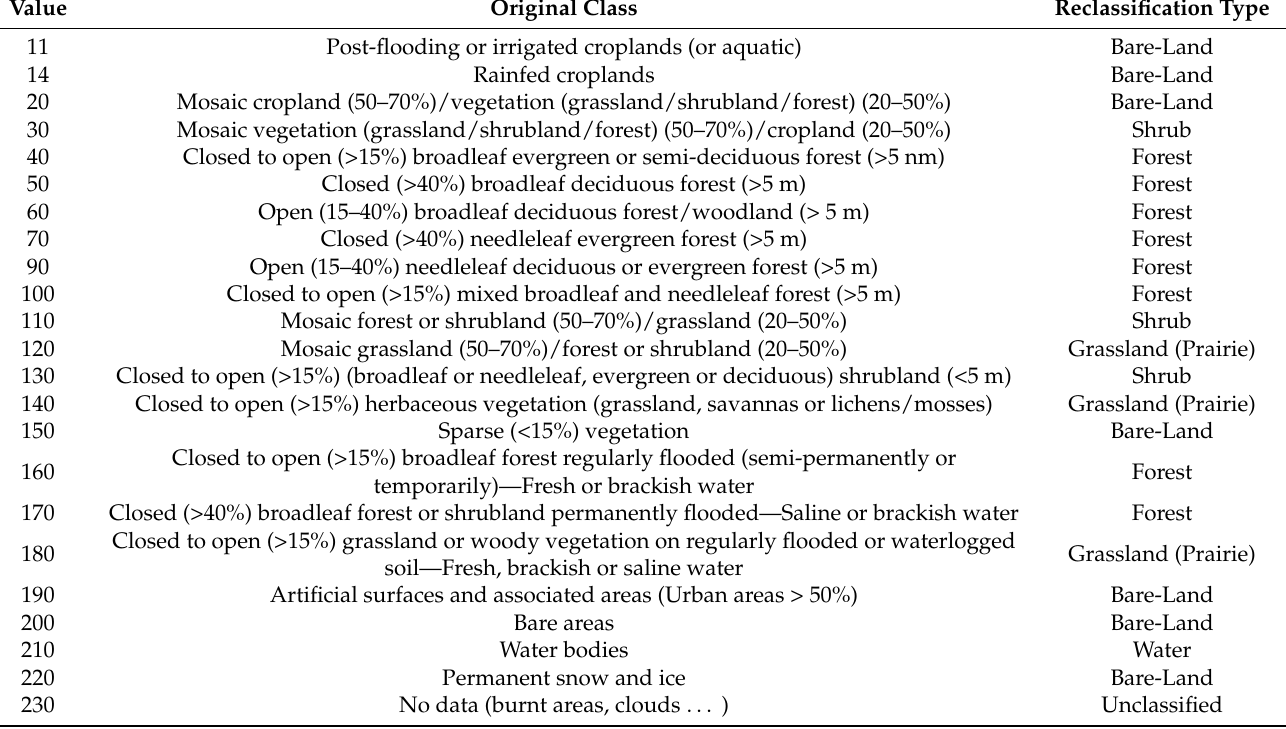
Table A1. Land cover type reclassification of the GlobCover2009 classification system.